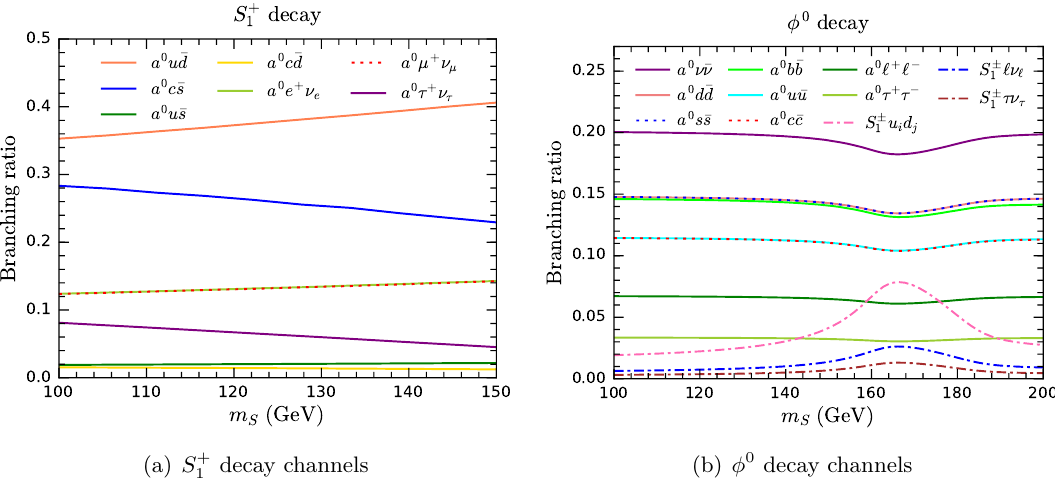
Figure 3 . Branching ratios of S + (a) and φ 0 (b) decay channels for λ + = 1 , λ − = 0 , and λ 3 = 0 . 5 . 1